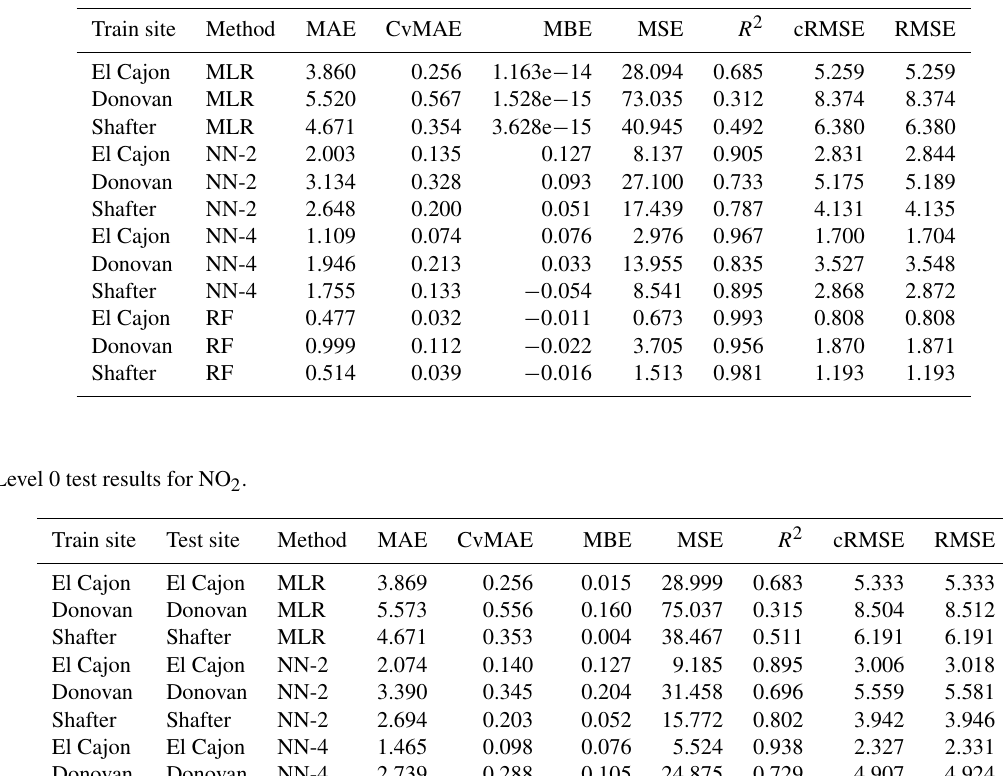
Table C1. Level 0 train results for NO 2 (train and test on the same data set).